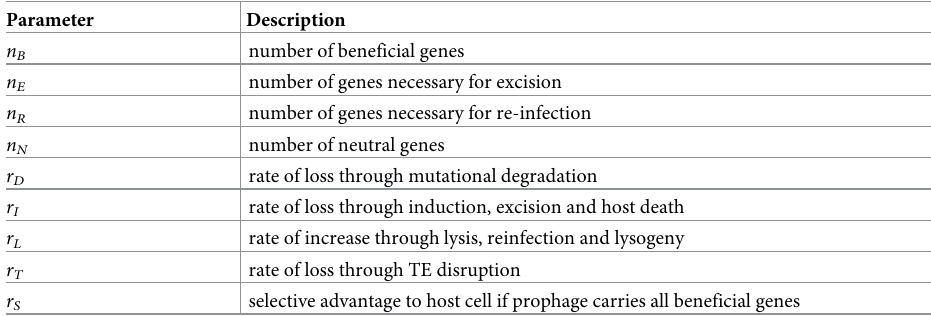
Table 4. Parameters of the computational